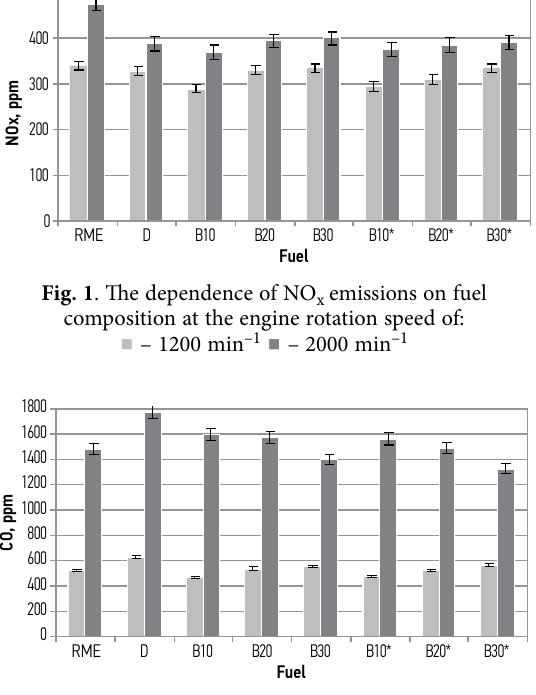
Fig. 3 . The dependence of HC emissions on fuel composition at the engine rotation speeds of: ■ – 1200 min –1 ■ – 2000 min